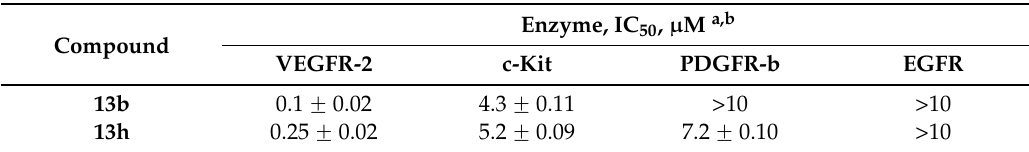
Table 4. Kinase selectivity of compounds 13b and 13h